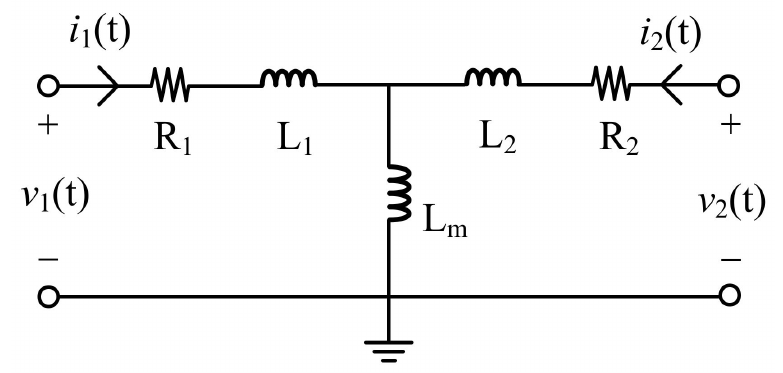
Figure 6. Configuration of an equivalent circuit for a single-phase